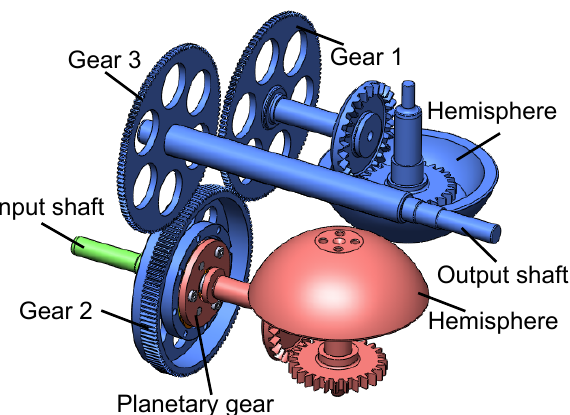
Figure 9. An image showing the drive train of the dual-hemi CVT. The use of colours is consistent with Figure 6: the parts connected to the ring gear of the planetary gear are blue, the parts connected to the cage of the planets of the planetary gear are coloured red and the parts connected to the sun gear of the planetary gear are coloured